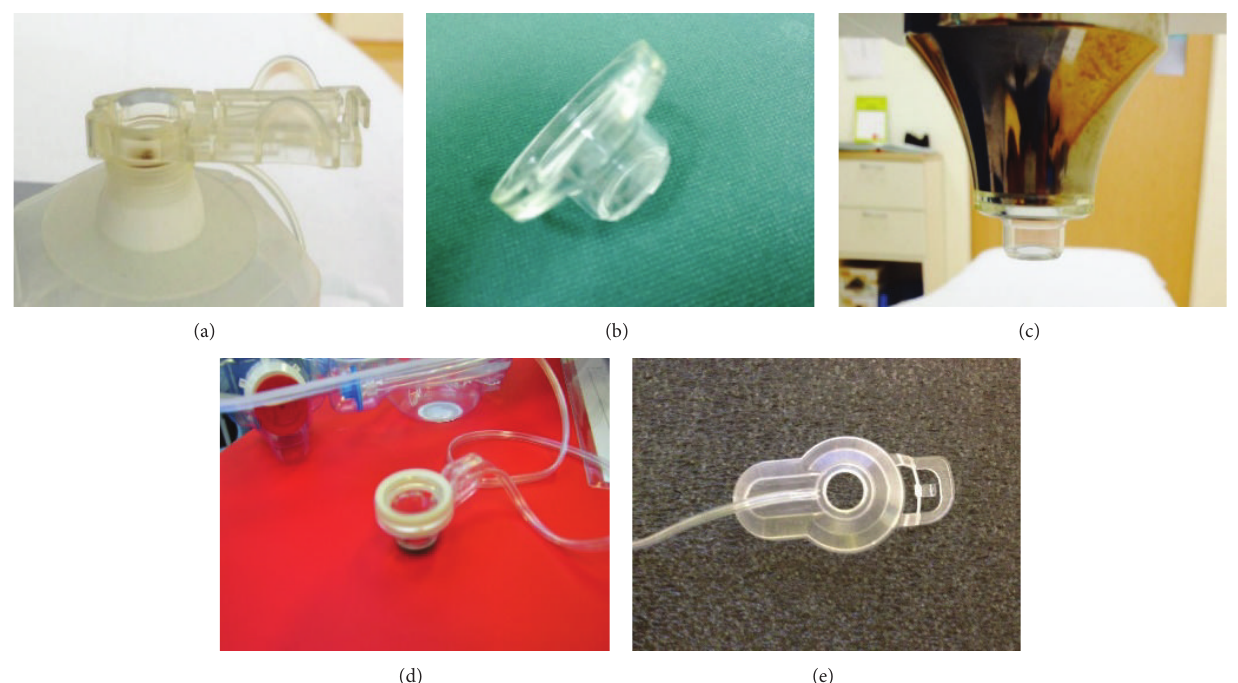
Figure 2: Docking devices for the three different femtosecond laser platforms. Victus suction ring (a) and curve applanation cone (b, c); Catalys suction ring (d); LDV Z8 suction ring